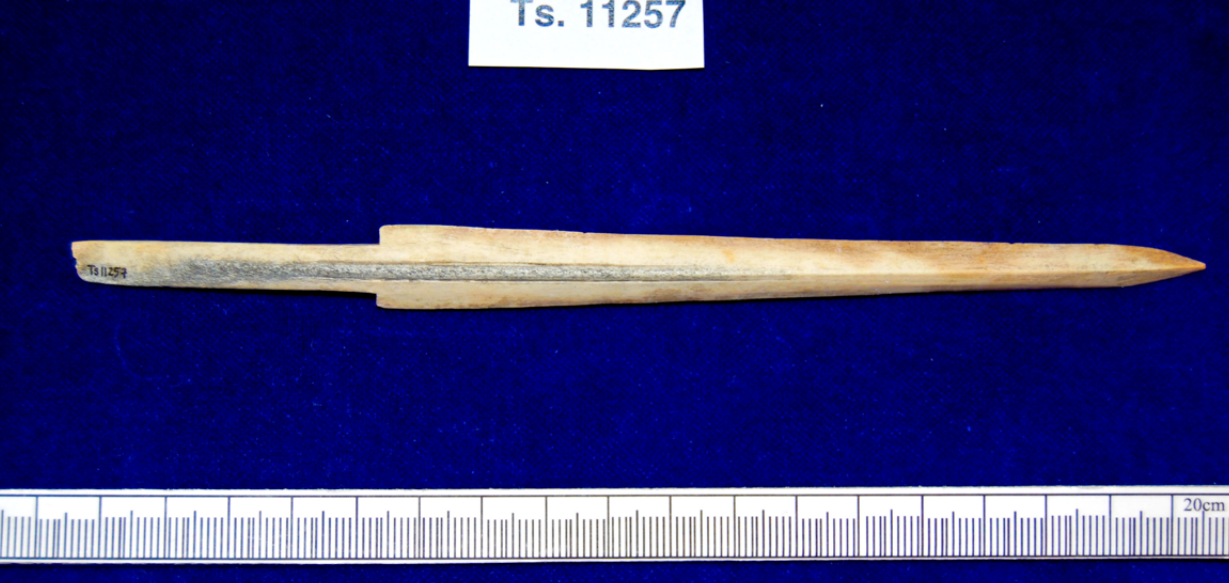
Figure 2. Reindeer antler arrowhead recovered from the western plateau of Seiland, possibly related to ice patches in the area. CC BY-NC-ND 3.0 (Photograph: Unimusportalen/I. Sommerseth). Historically, the reindeer herding Sami population of Finnmark has used the island as a summer pasture for their flocks. This is still true today, and the island is divided into two administrative pasture zones belonging to the siida (i.e., cooperative Sami family groups) Seiland west and east. According to Vorren [24], who carried out an extensive investigation into reindeer-herding Sami migratory patterns in the period 1953–57, there were three Sami siida groups using Seiland as summer pasture for their reindeer herds, consisting of twelve families. Two of these siida still pasture herds in the southern part of the island, while the third group uses the northeastern peninsula. All of them have winter pastures in the Kautokeino-Karasjok region and migrate seasonally between the interior and the coast